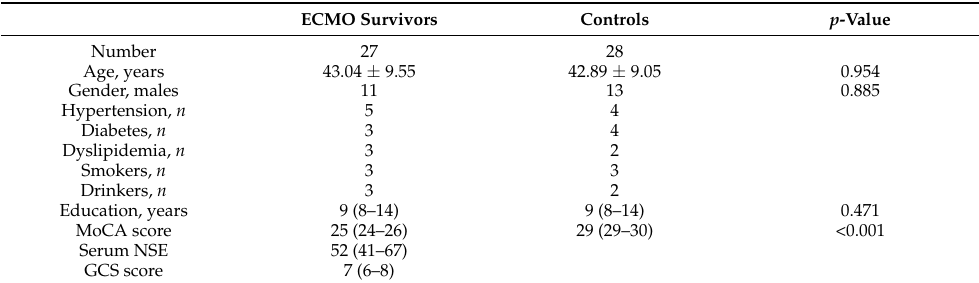
Table 1. Demographics of our study